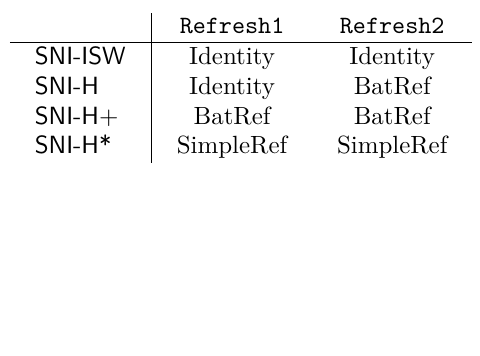
Table 1: Refreshing gadgets used for various multiplication gadgets. BatRef is the SNI refresh gadget of Battistello et al. ([BCPZ16], Algorithm 6). SimpleRef is a NI